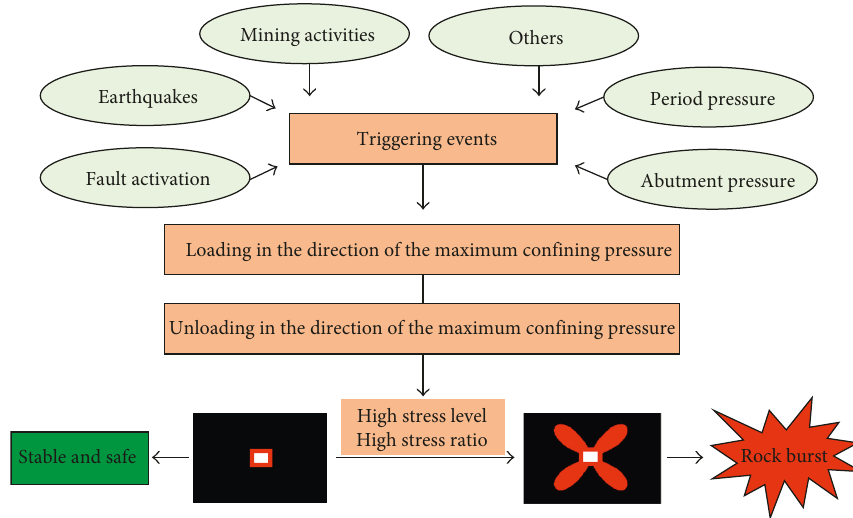
Figure 8: Mechanism of roadway rockburst.